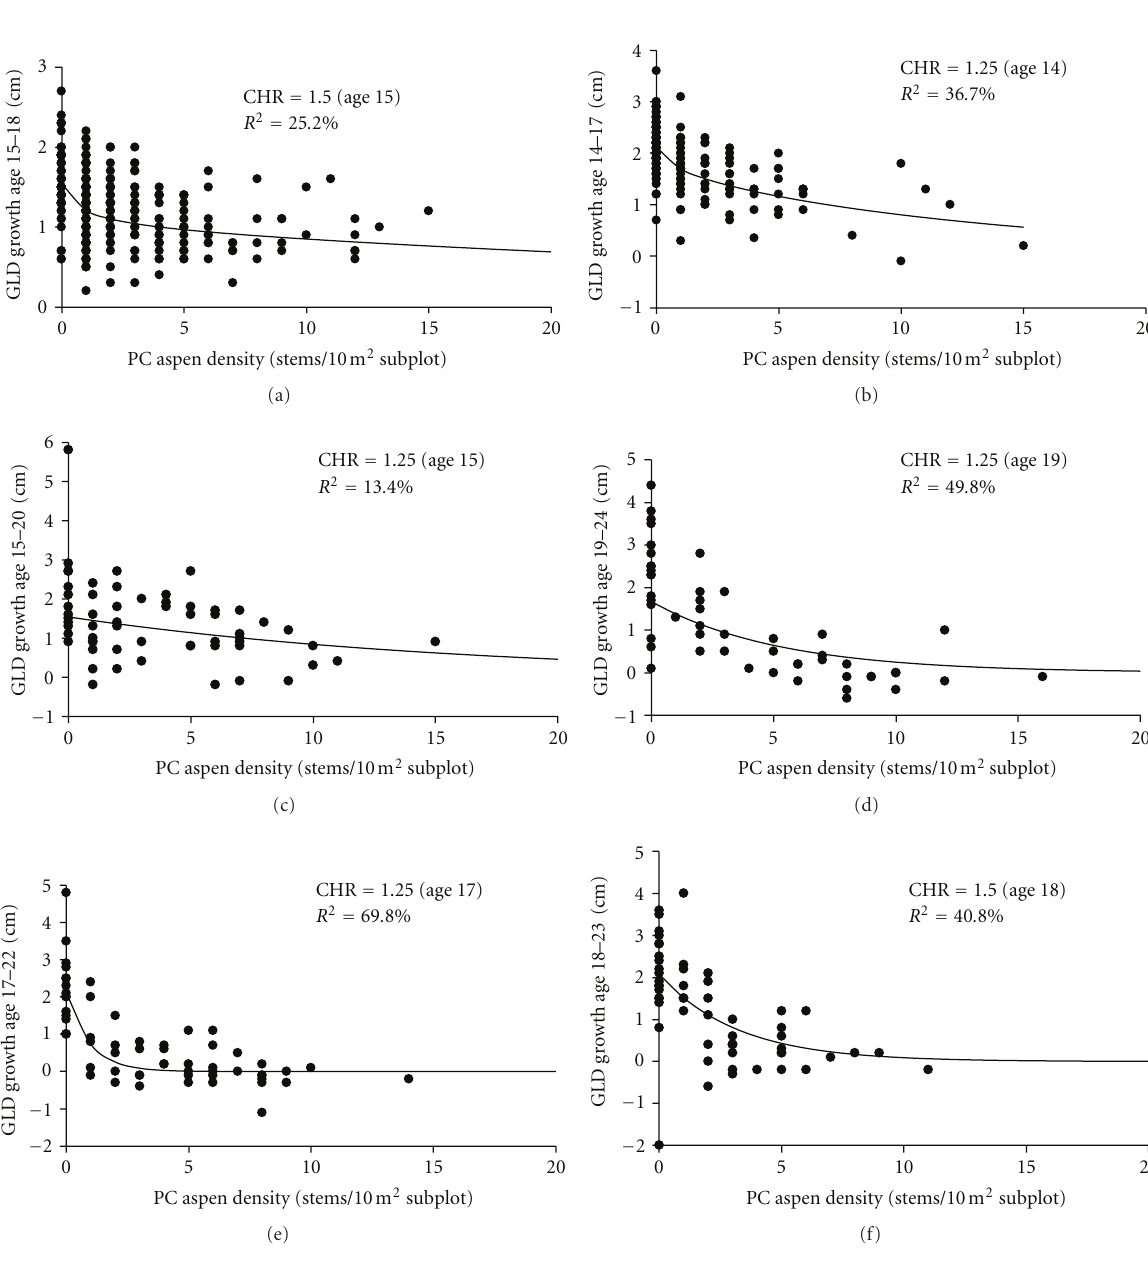
Figure 2: Scatterplots and fitted regression curves predicting lodgepole pine diameter growth from principal competitor aspen density determined at age 14–19 years at the six study sites: (a) SBPSxc; (b) IDFdk3-A; (c) IDFdk3-B; (d) IDFdk3-C; (e) SBSdw1-A; (f)